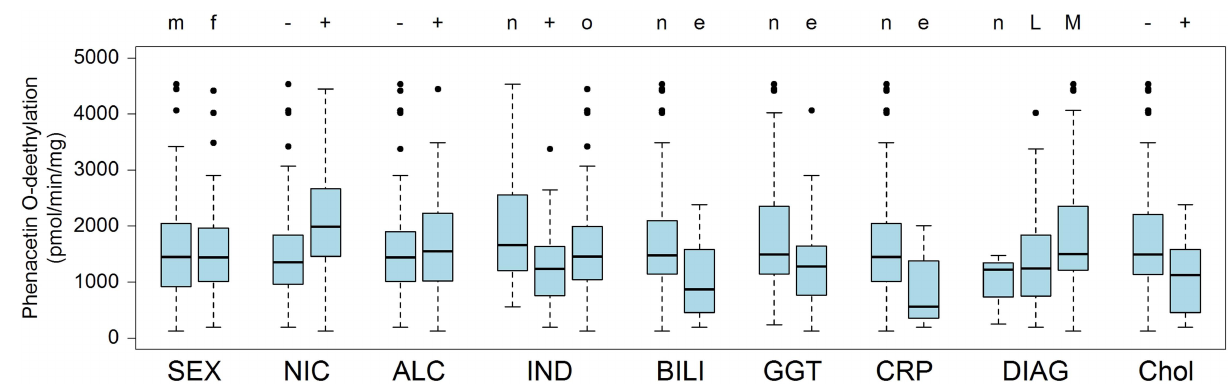
Figure 3 | CYP1A2 enzyme activity in population subgroups. The liver donors ( n = 150) were divided into subgroups according to available clinical documentation on environmental exposures and other non-genetic factors: SEX, (m) male, (f) female; NIC, nicotine consumption, ( − ) non-smokers ( + ) smokers ( > 1 cigarets/day); ALC, alcohol consumption ( − ) none ( + ) > 1 times/week; IND, (n) no drugs, ( + ) known inducers of P450, (o) other drugs; BILI, serum bilirubin, (n) value in normal range, (e) elevated value; GGT, serum gamma glutamyl transferase, (n) value in normal range, (e) elevated value; CRP, C-reactive protein,